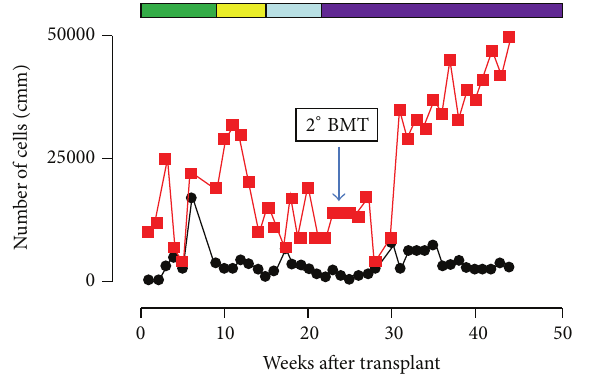
Figure 1: Haematological reconstitution in a 5 year old girl with SAA after first BMT (time 0) and second (22 weeks later). Black line = white blood cell counts; red line platelet counts. Coloured bars = immunosuppressive agents to prevent GvHD. Green = cyclosporine; Yellow = tacrolimus; Light blue = mycophenolate and Purple =